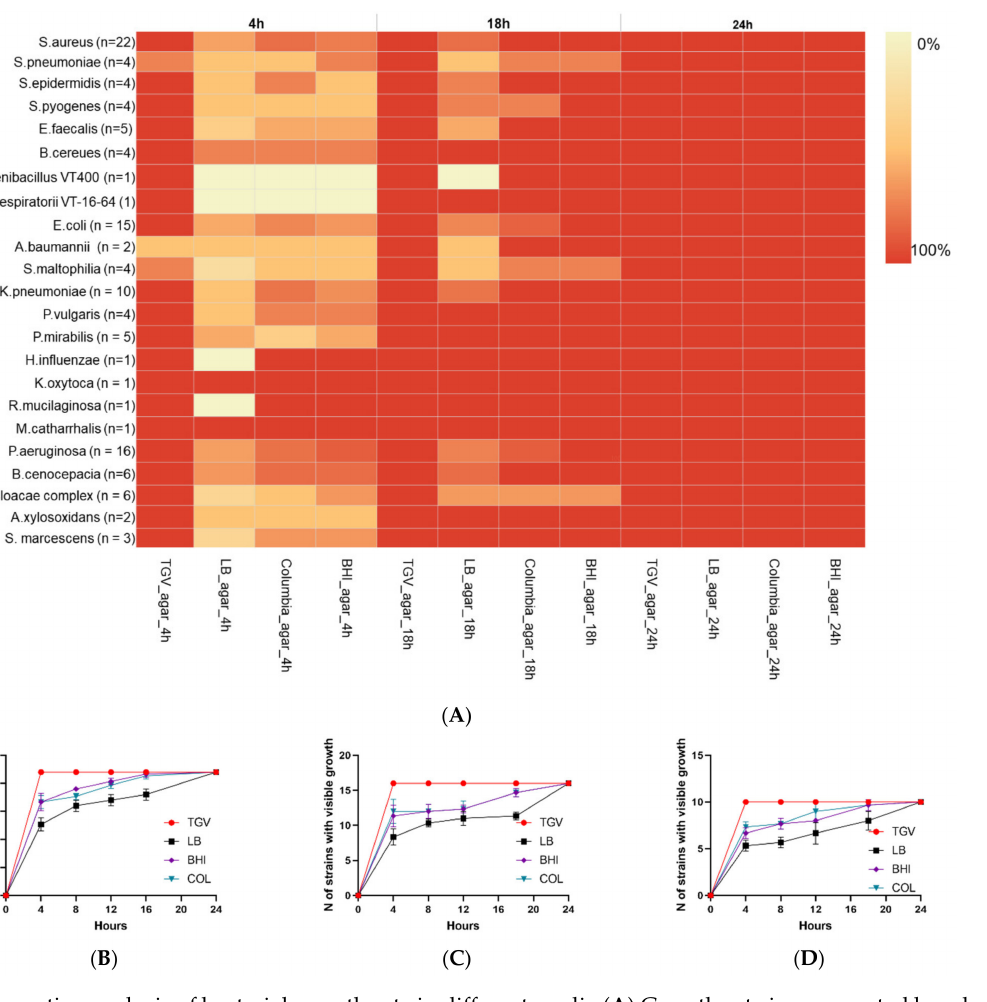
Figure 1. Comparative analysis of bacterial growth rate in different media ( A ) Growth rate is represented by a heat map, with each cell indicating the percentage of bacterial strains that showed growth at 4, 8, or 24 h. Red color intensity represents the highest rate of growth, whereas white color indicates no growth for a particular time period. ( B ) Number of S. aureus strains out of 22 tested that showed visible growth at different time periods on different media: TGV agar (TGV), LB agar (LB), Columbia agar (COL), brain heart infusion agar (BHI). ( C ) Number of P. aeruginosa strains out of 16 tested that showed visible growth at different time periods on TGV, LB, COL, or BHI. ( D ) Number of K. pneumoniae strains out of 10 tested that showed visible growth at different time periods on TGV, LB, COL, or